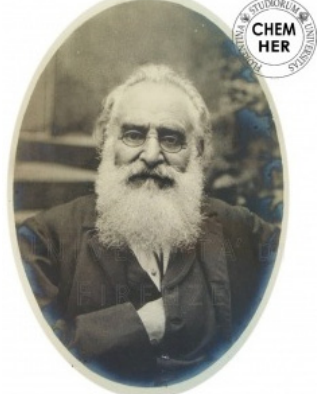
Figure 1. A portrait of Hugo Schiff.